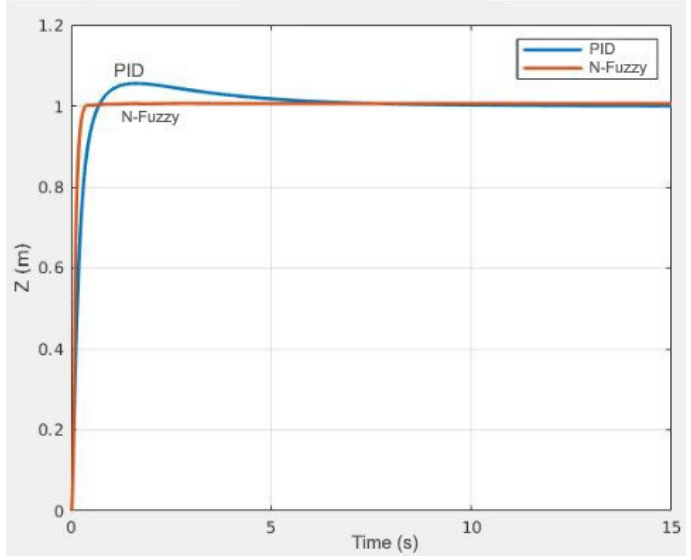
Figure 20. The results compare the Z position (attitude) of the Neural-Fuzzy controller and the classic PID controller (no wind).